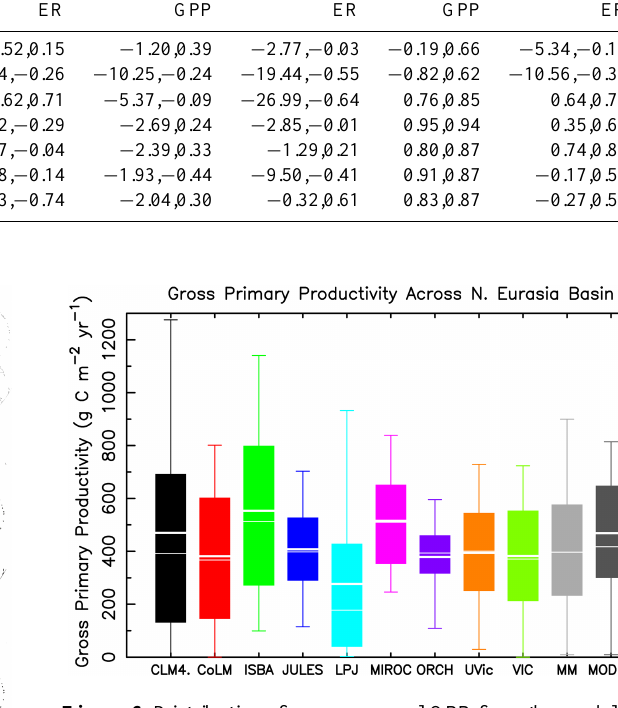
Figure 6. Distributions for mean annual GPP from the models and the MOD17 product over the averaging period listed in Fig. 5. The rectangles bracket the 25th and 75th percentiles. Whiskers extend to the 5th and 95th percentiles. Thick and thin horizontal lines mark the mean and median